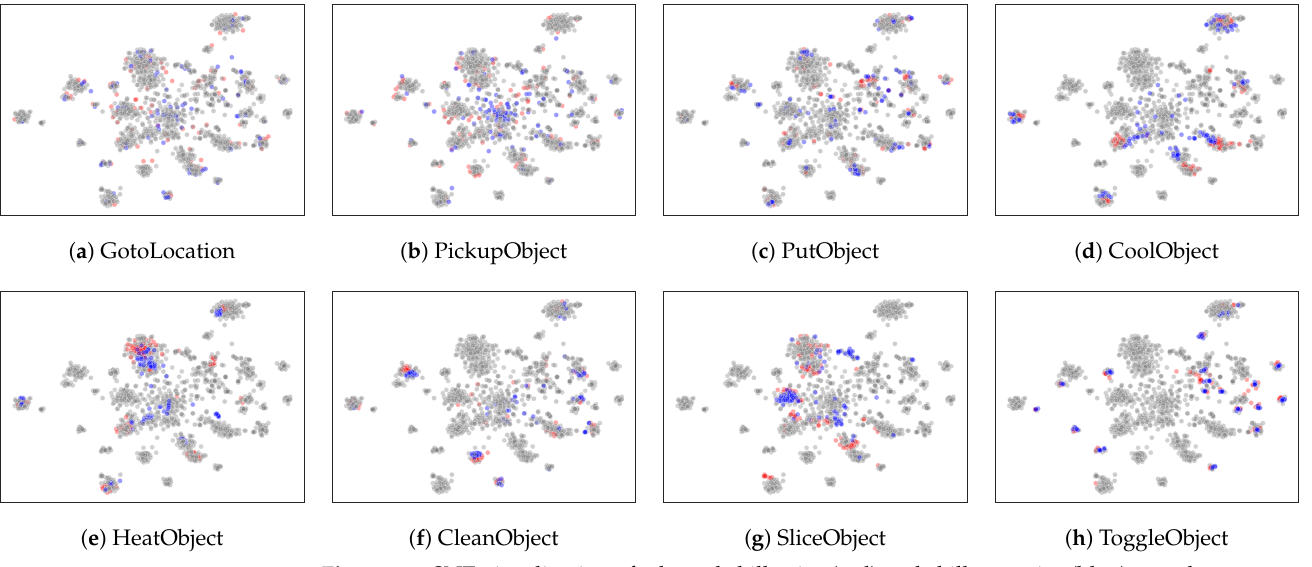
Figure 5. t-SNE visualization of adapted skill prior (red) and skill posterior (blue) samples. Samples from the adapted skill prior are associated with samples from the skill encoder (skill posterior). In Figure 5c–h, most of the samples from the skill prior are distributed in the same clusters with the samples from the skill posterior. This indicates that